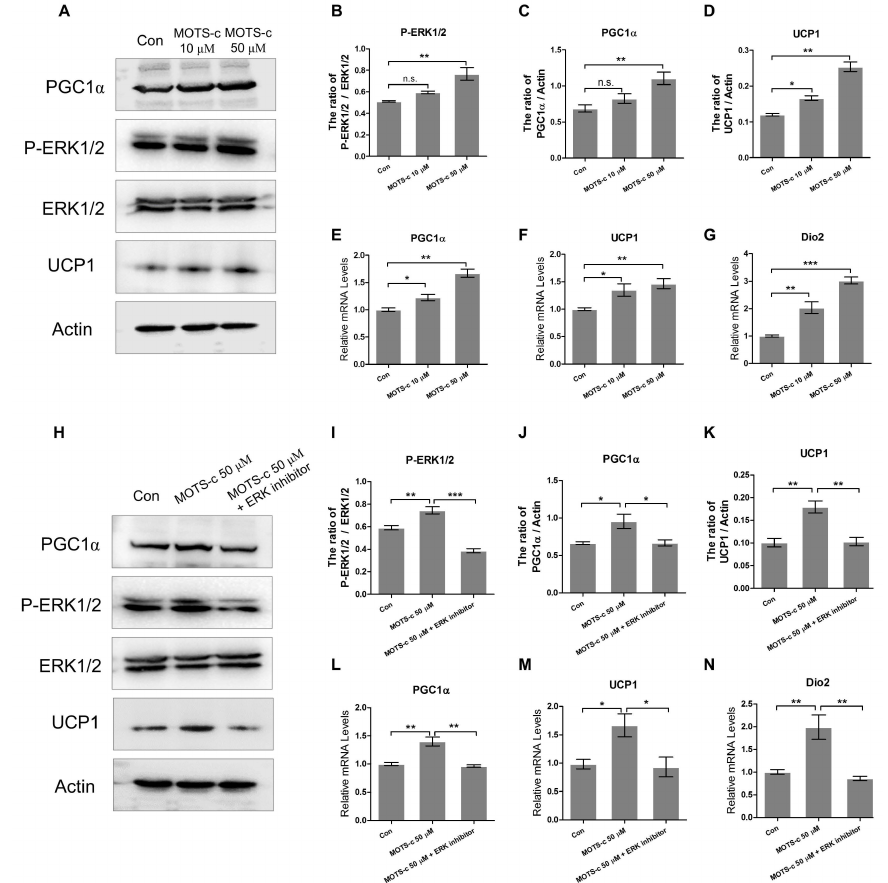
Figure 4. MOTS-c triggers thermogenic genes program via the ERK signaling pathway. ( A – D ) The protein levels of phospho-ERK1 / 2, PGC1 α , and UCP1 in adipocytes treated with MOTS-c and immunoreactive bands were quantified by densitometric analysis using ImageJ ( n = 4, per group). ( E – G ) The RNA level of thermogenic genes (PGC1 α , UCP1, and Dio2) ( n = 4, per group). ( H – K ) The level of phospho-ERK1 / 2, PGC1 α , and UCP1 in adipocytes treated with MOTS-c and ERK inhibitor, and immunoreactive bands were quantified by densitometric analysis using ImageJ ( n = 4, per group). ( L – N ) The RNA level of thermogenic genes (PGC1 α , UCP1, and Dio2) ( n = 4, per group). All data are represented as mean ± SEM. Di ff erences between the two groups were determined by a two-tailed Student’s t-test. * p < 0.05, ** p < 0.01, *** p < 0.001, n.s. = not